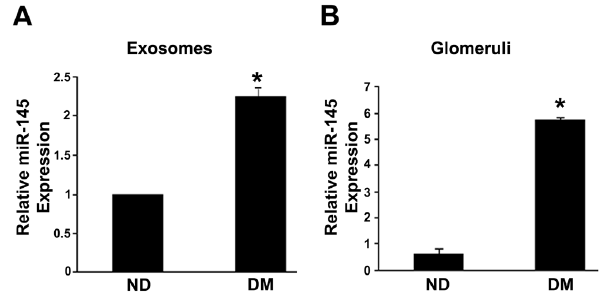
Figure 1. Expression of miR-145 in experimental diabetes. MiR-145 levels were measured by qRT-PCR in both urinary exosomes ( A ) and isolated glomeruli ( B ) from diabetic (DM) and control (ND) mice as described in the Methods. Results, corrected for the expression of housekeeping U6 snRNA, are shown in the graphs (*p<0.001 DM vs ND).